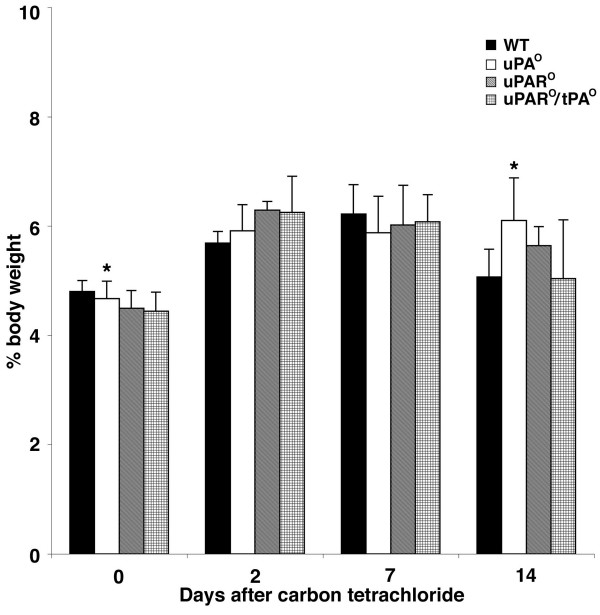
Maintenance of liver mass following CCl 4 . Analysis of the liver mass (expressed as the wet liver weight as a percentage of the body weight) shows a mild increase in all genotypes 2 days after CCl4 administration, followed by a trend toward baseline levels by 14 days, except for livers of uPA° mice which continue to display a mass that is similar to day 2 (and higher than before CCl4, *P < 0.03). WT = wild type.